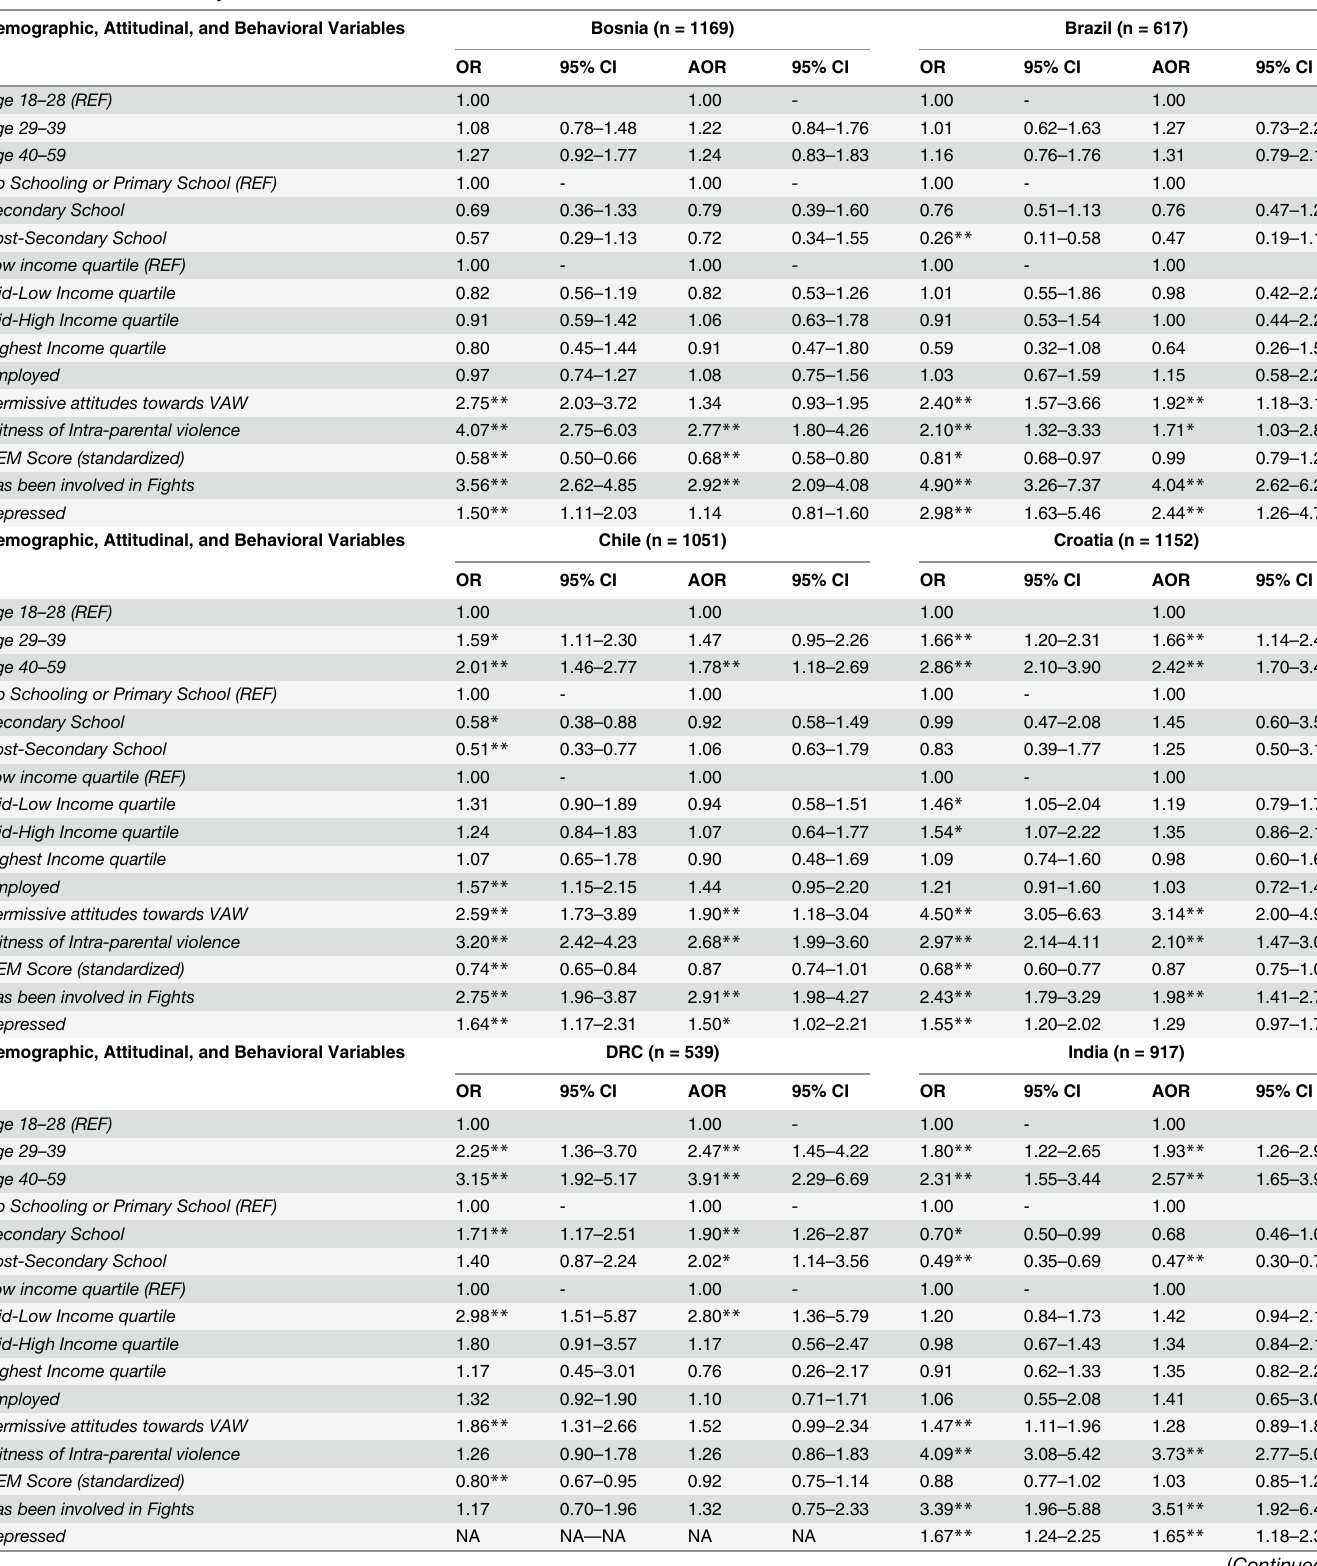
Table 4. Results from multivariate logistic regression, correlates of lifetime physical violence perpetration against a partner, presented as unad- justed odds ratios and adjusted odds ratios a. Demographic, Attitudinal, and Behavioral